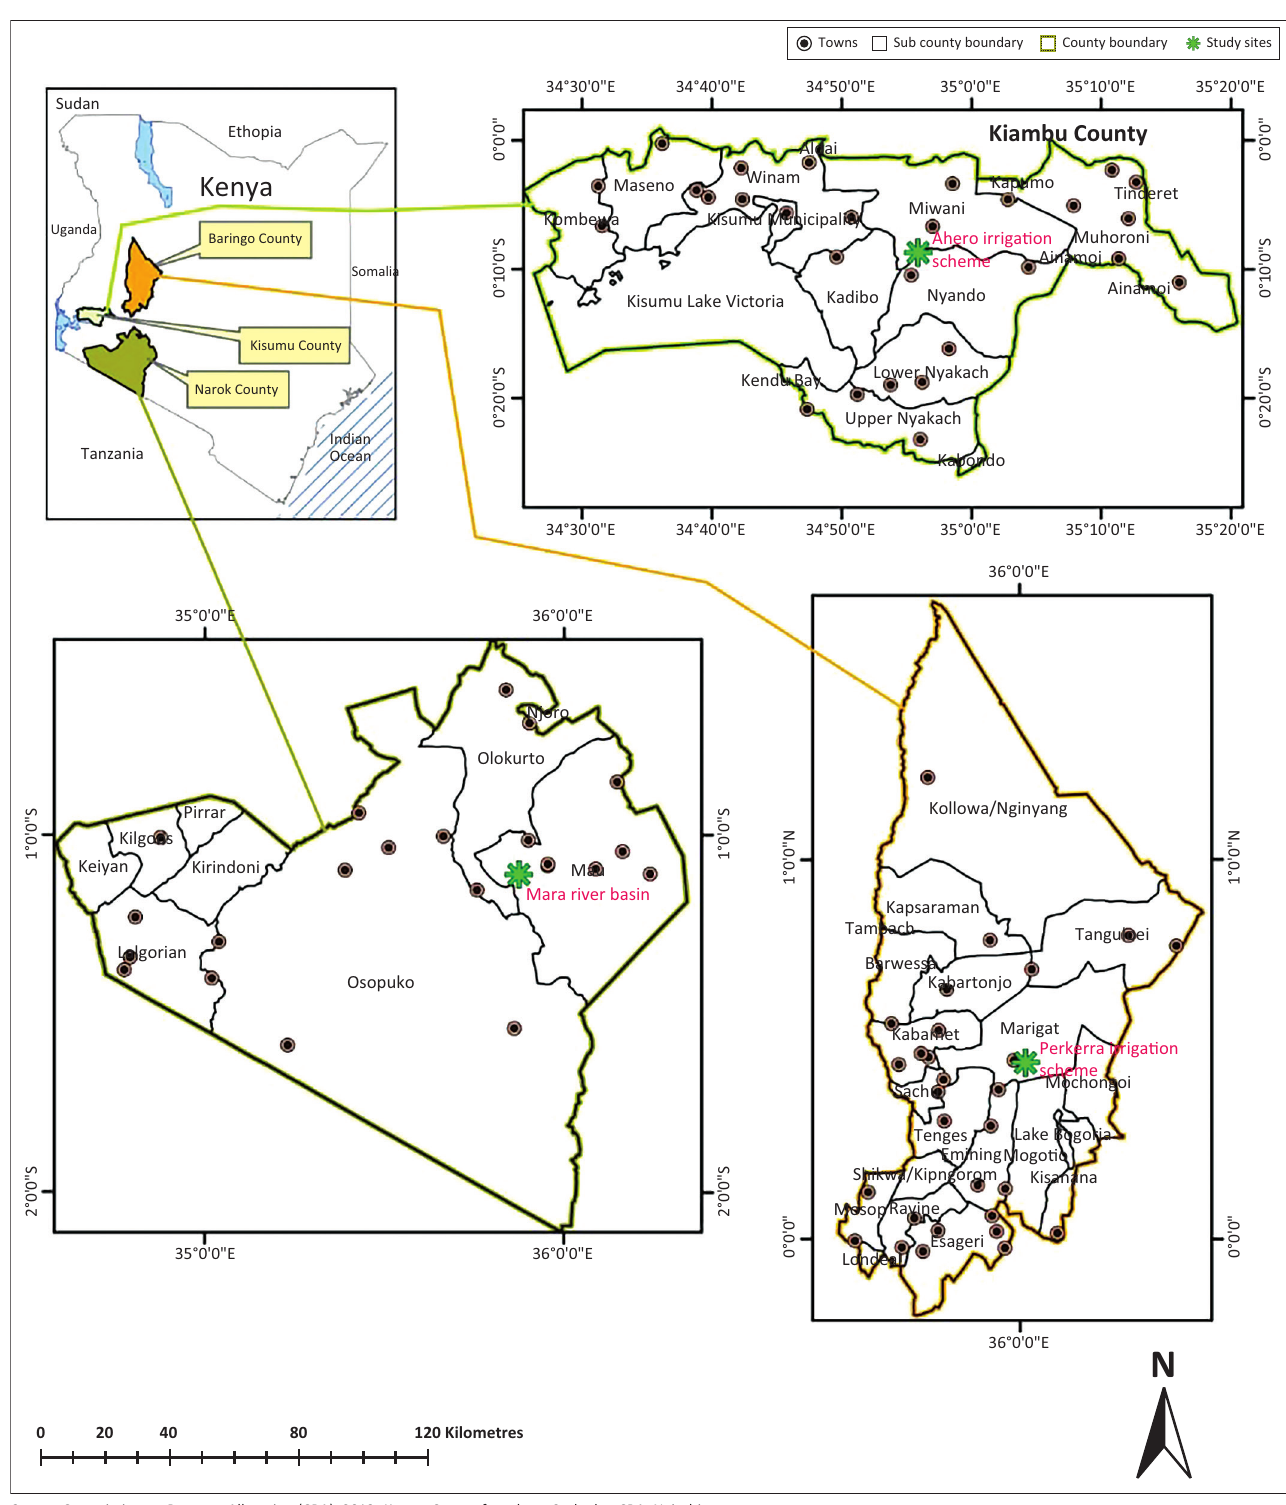
FIGURE 1: Map of Kenya showing the location of Narok, Ahero and Baringo Counties, where the samples were